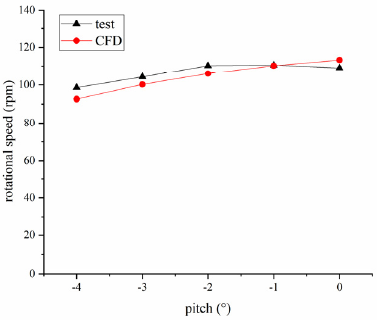
Figure 9. Rotational speed with θ at δ s = 40 ◦ , v = 0.306 m/s .